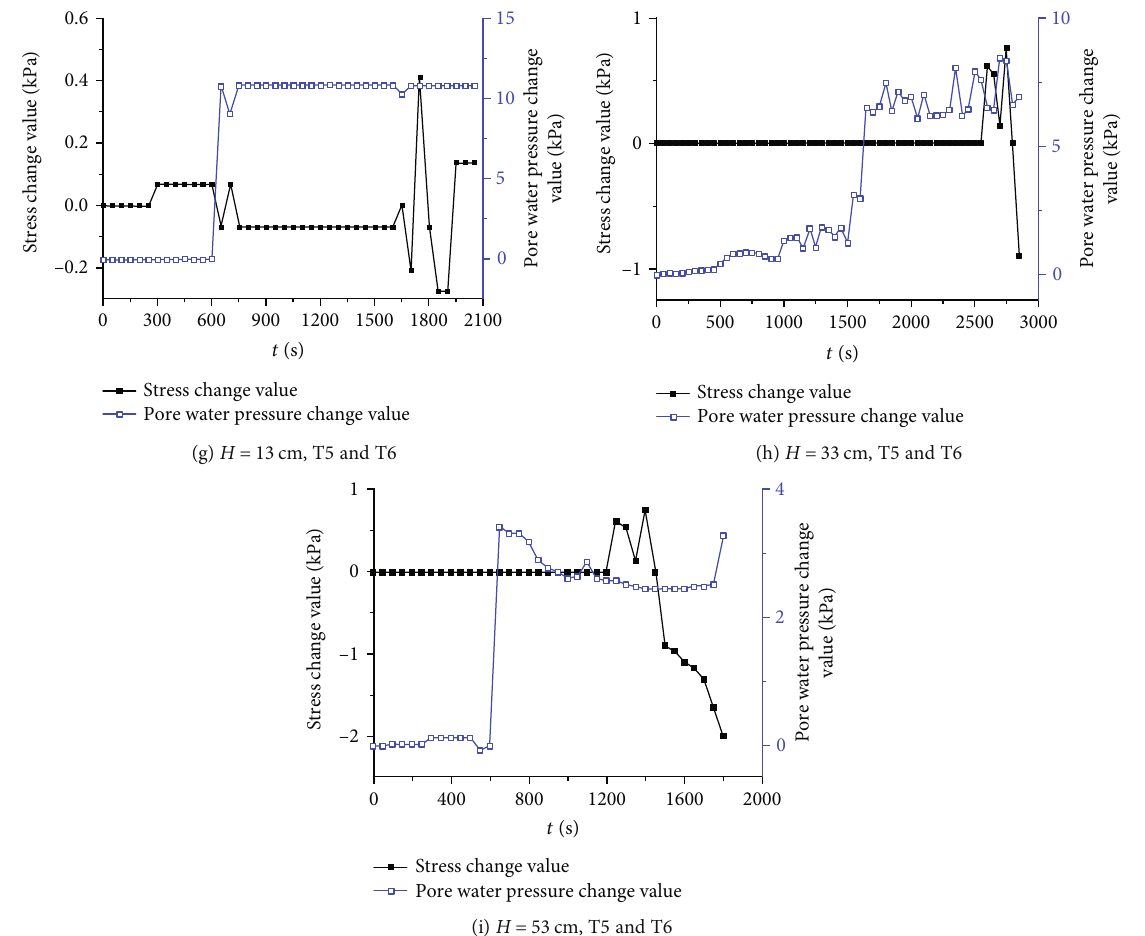
Figure 8: Variation of wall rock stress and pore water pressure in di ff erent conditions of seepage path.